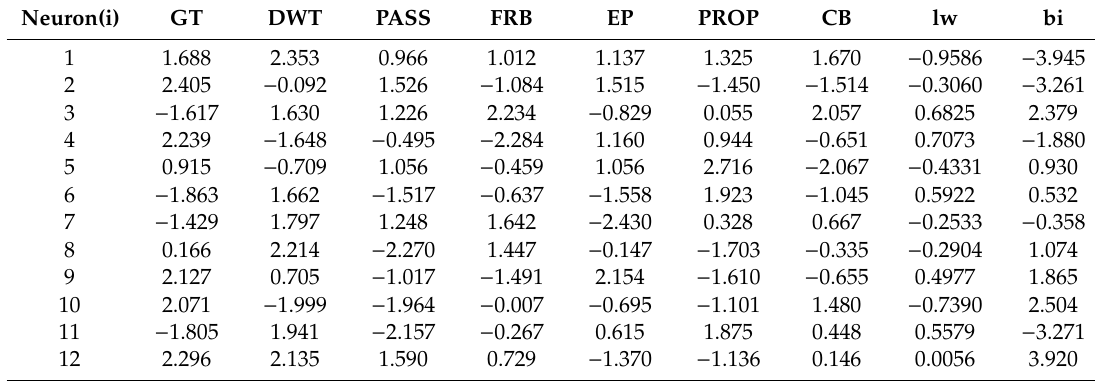
Table 3. The weights and the biases of the first layer (hidden layer).